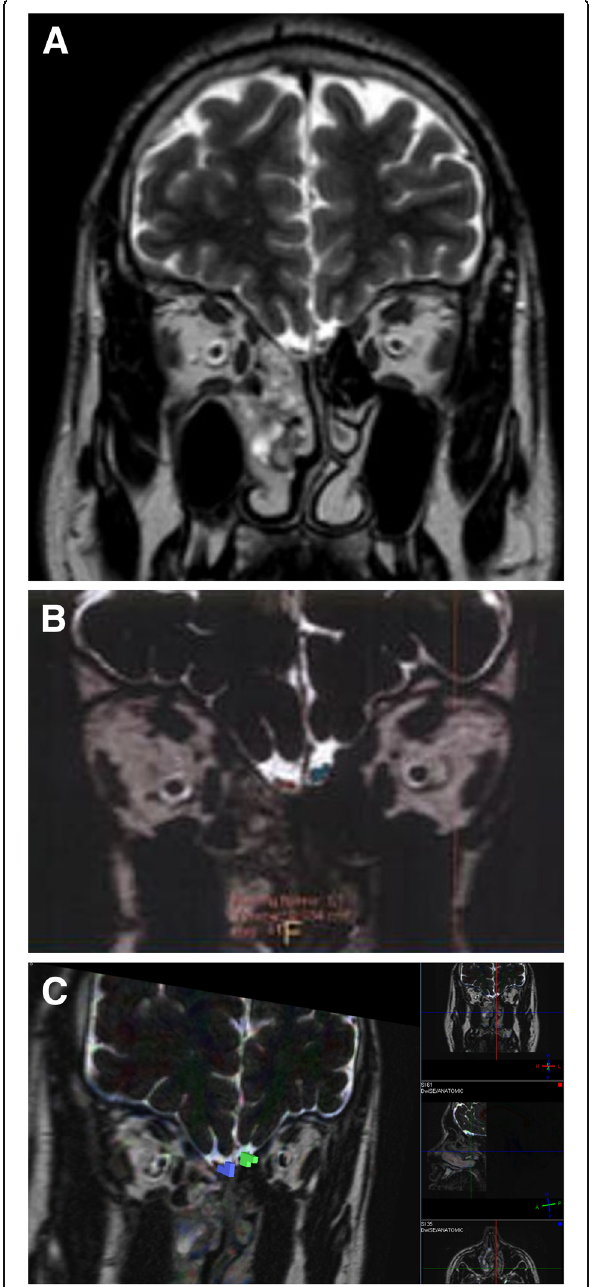
Fig. 2 Bilateral sinonasal polyposis with hyposmia. 3D DRIVE ( a ) for accurate localization of the OB (circle). MR volumetry (not shown) revealed largest left OB. MR tractography ( b ) revealed higher FA and lower ADC values for left tract (blue tract) keeping with more compact fibers. The parameters of the two tracts are still beyond the author ’ s cutoff value